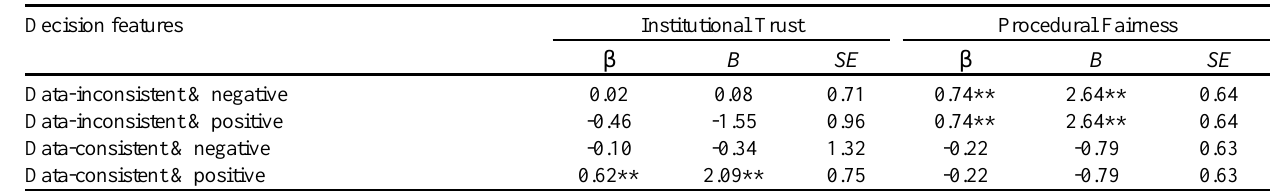
Table 4 . Situationally specific prediction of final compliance by institutional confidence and perceived procedural fairness. Decision